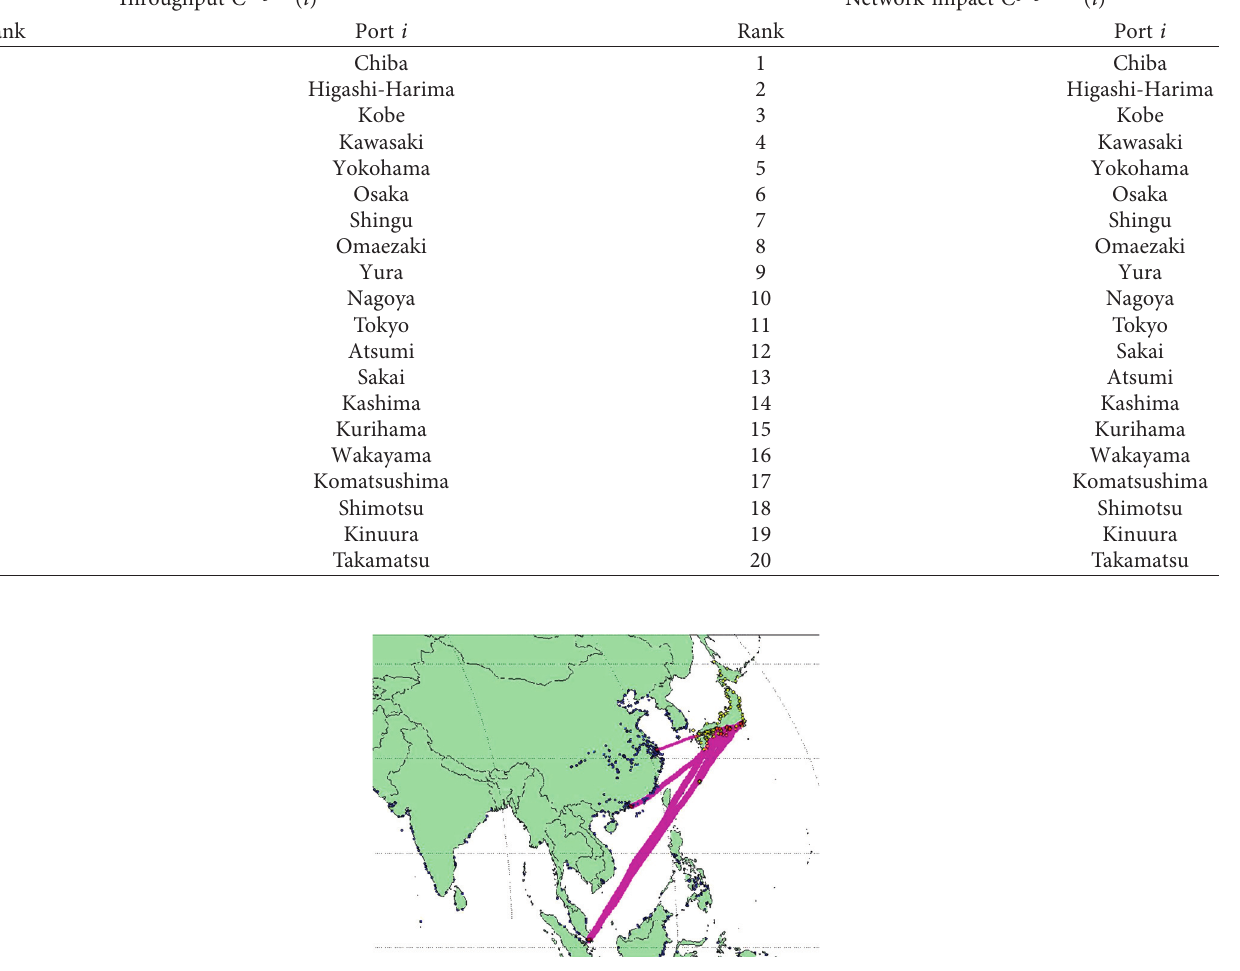
Figure 9: Primary flows between the Japanese ports and the Table 10: Top 20 connections between Japan and the MSR.